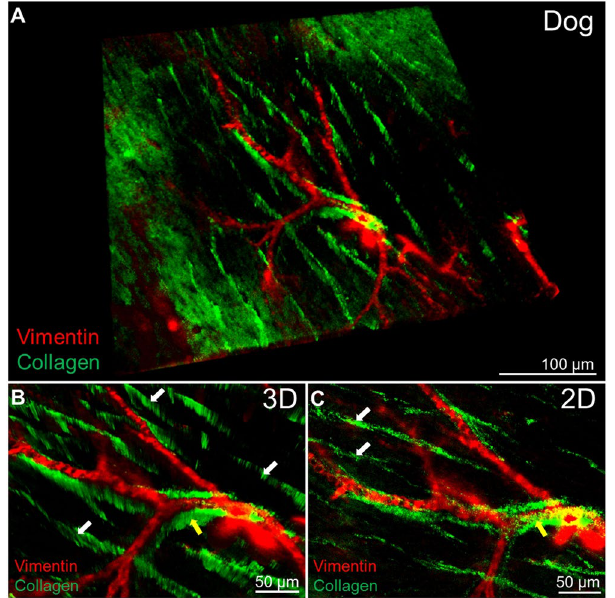
Figure 5. Combination of collagen type 1 imaging and macrovasculature staining. ( A ) Three dimensional reconstruction of the collagen (green) distribution in proximity to large vessels (vimenitin positive, red). ( B , C ) 3D and 2D higher magnification shows how the collagen separates myocardial muscle fibres (white arrows) but also surrounds larger vessels (yellow arrows). At least 3 slices were used for each